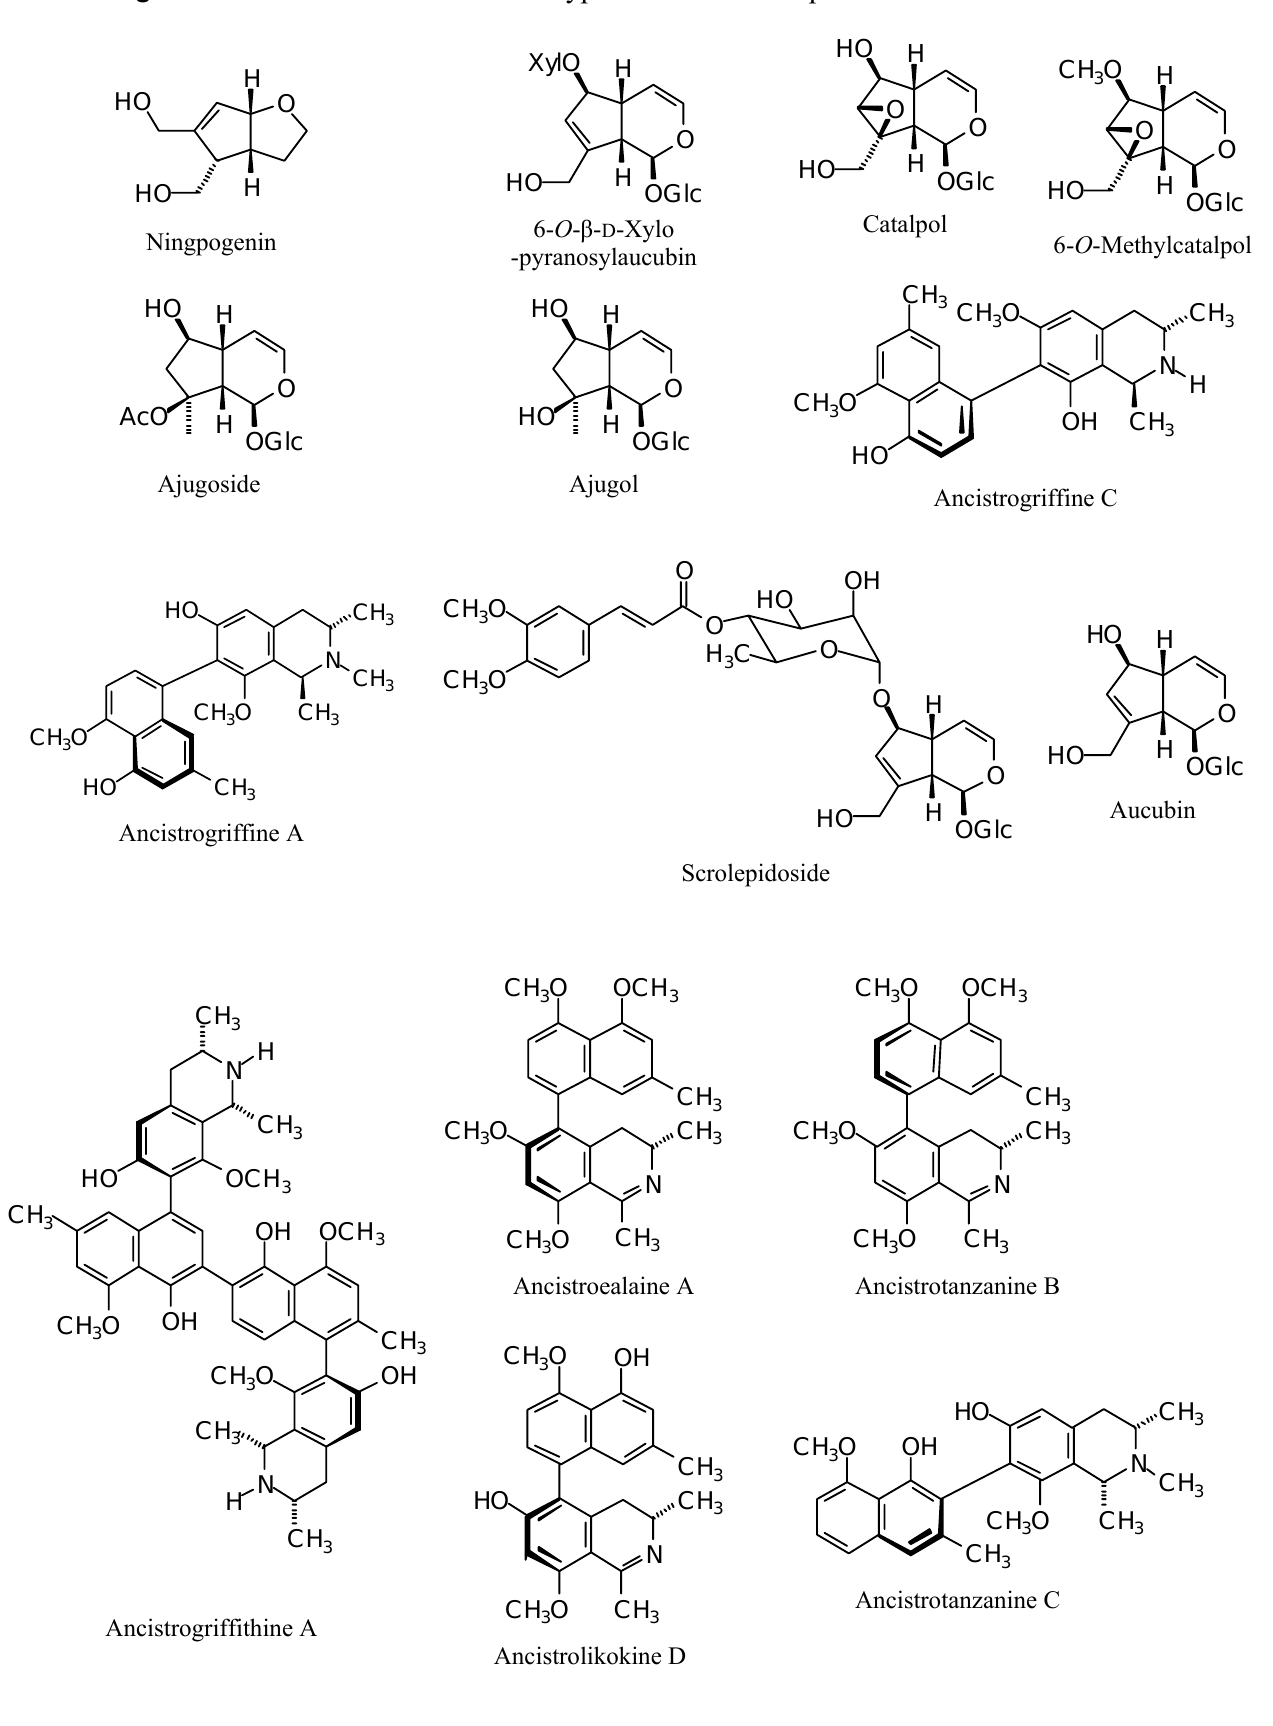
Figure 10. Structures of docked antitrypanosomal natural products discussed in this